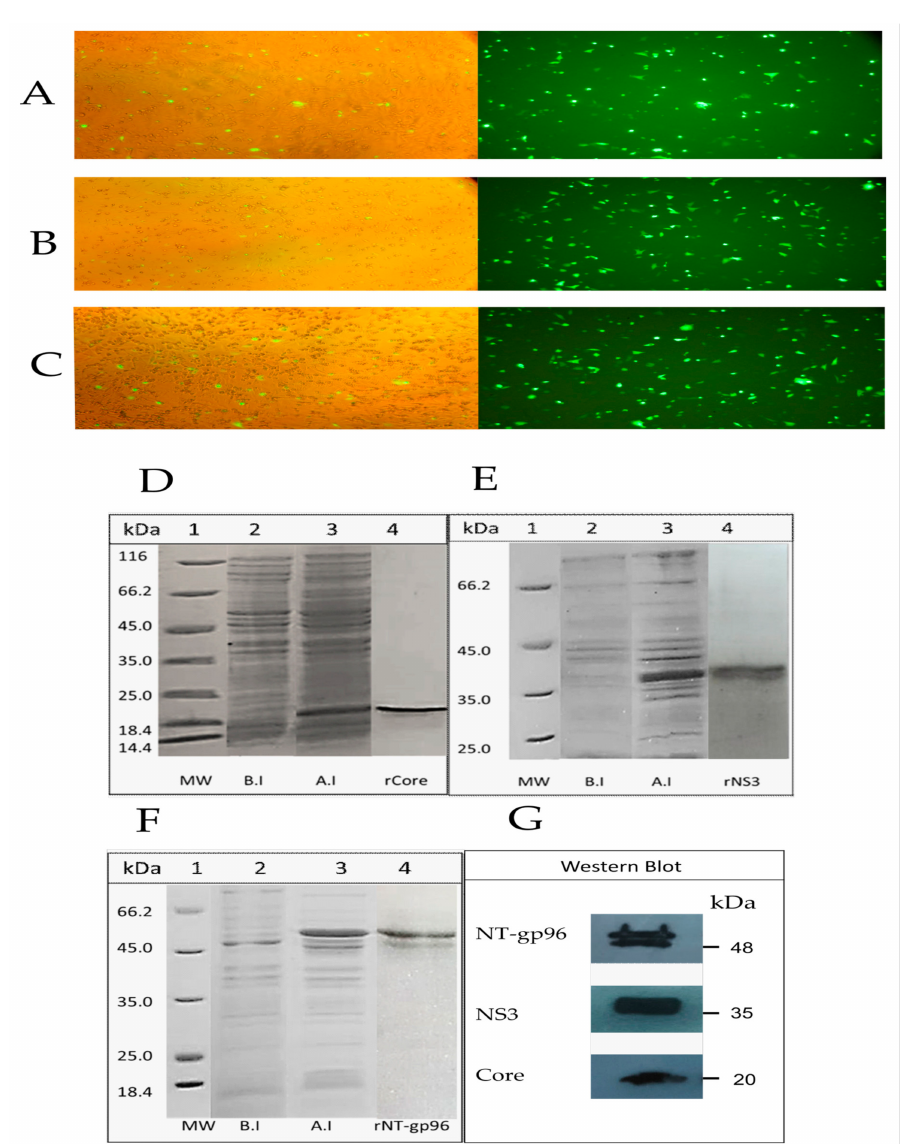
Figure 2. In vitro expression of Core-NS3-EGFP and Core-NS3-NT (gp96)-EGFP in COS-7 cells. ( A – C ) Recombinant pEGFP-Core-NS3, pEGFP-Core-NS3-NT (gp96), and pEGFP-N3 plasmids were transiently transfected into COS-7 cells using polyethyleneimine. GFP expression of the transfected cells (before and after glinting fluorescence) with pEGFP-N3 (as positive control), pEGFP-Core-NS3, and pEGFP-Core-NS3-NT (gp96), respectively. SDS-PAGE analysis of rCore ( D ), rNS3 ( E ), and rNT (gp96) ( F ) proteins: Molecular weight markers (lane 1), bacterial extract before induction by IPTG (lane 2), crude bacterial lysate 4 h after induction (lane 3) and recombinant proteins purified from bacterial lysates by affinity chromatography using Ni-NTA matrix (lane 4). ( G ) Western blot analysis of purified recombinant proteins using anti-His mAb and goat anti-mouse IgG